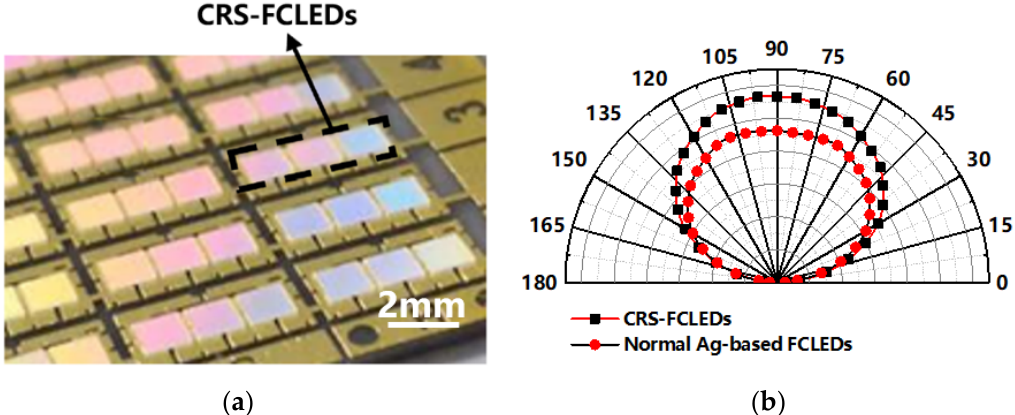
Figure 8. ( a ) LED high power module with dense matrix package. ( b ) Far-field radiation pattern of CRS-FCLED and normal Ag-based FCLED at 1500 mA.